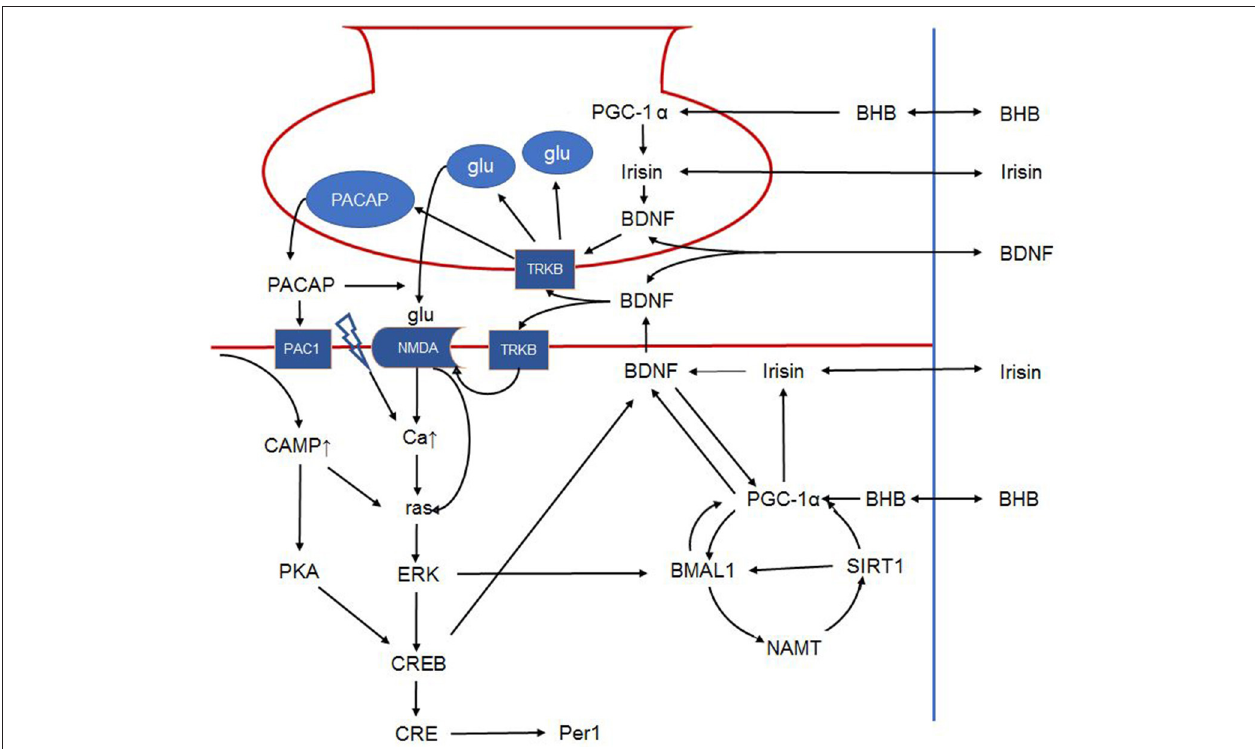
FIGURE 3 | Schematic outline of the intracellular signalization in the retinohypothalamic tract. Presynaptically, BDNF can increase glutamate and PACAP content of synaptic vesicles and facilitates their release. Postsynaptically, BDNF phosphorylates the NMDA receptor, increasing its number and the opening probability of the channel. BDNF furthermore enhances PACAP release. PAC1 receptor activation activates CREB via the cAMP-protein kinase A pathway. NMDA receptor activation leads to ras activation directly and indirectly by increasing intracellular calcium. Ras in turn activates ERK that on one hand activates CREB, and on the other phosphorylates BMAL1. In addition, BMAL1 is regulated by the NAMPT-SIRT1, PGC-1 α cycle. Peripheral signals may further influence these complex interactions. For example, BHB induces PGC-1 α that in turn induces irisin expression. Irisin’s influence on BDNF expression and release is hypothetical in the SCN, however it was described in other brain areas. Hence, in the present article, we propose that peripheral signals (BHB, irisin etc.) liberated in response to non-photic environmental signals may modulate the permissive effect of BDNF. The link between irisin and BDNF in the SCN is hypothetical. BDNF: brain-derived neurotrophic factor; PACAP: pituitary adenylate cyclase-activating polypeptide; NMDA, N-methyl-D-aspartic acid; PAC1, pituitary adenylate cyclase-activating polypeptide type 1 receptor; CREB, cAMP response element-binding protein; cAMP, cyclic adenosine monophosphate; ERK, extracellular signal–related kinase; BMAL1, brain and muscle ARNT-like protein 1; NAMPT, nicotinamide phosphoribosyltransferase; SIRT1, sirtuin 1; PGC-1 α , peroxisome proliferator-activated receptor γ coactivator 1 α ; BHB, β -hydroxybutyrate; SCN, suprachiasmatic